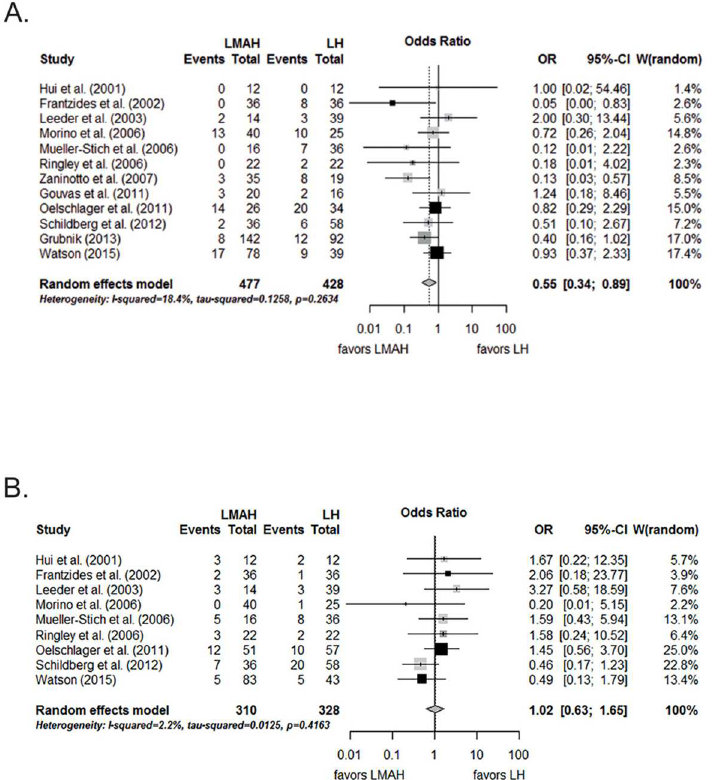
Fig 4. Meta-analysis of A) hernia recurrenceand B) complications after LMAH and LH. Black rectangles are randomized controlledtrials; dark gray rectangles are case control studies; light gray rectangles are case series with control group. LMAH, laparoscopic mesh augmented hiatoplasty; LH, laparoscopic hiatoplasty; OR, Odds Ratio; 95% CI, 95% confidenceinterval. Studies includedin the meta-analysis are detailedin the supporting informationfiles (S1